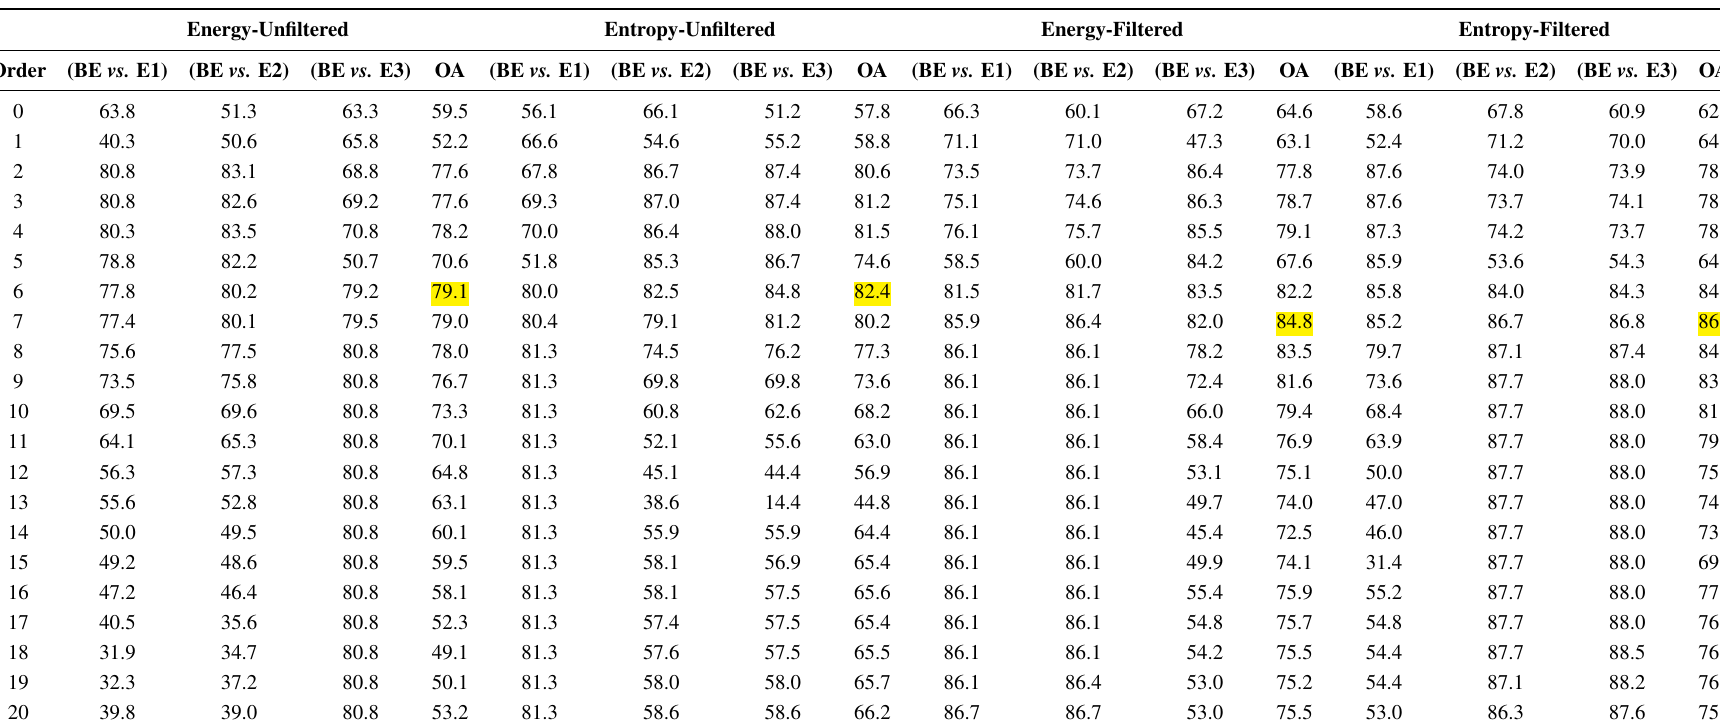
Table 3. Leave-one-out heat stress classification performance on PPG-chemical, biological and radiological (CBR) responders in the tropical condition database. Four classification methods are used in this analysis: linear discriminant analysis, quadratic discriminant analysis and the linear support vector machine. The PPG signals were collected from 40 heat acclimatized emergency responders for 20 s during the 10-minute break of each exercise ( cf. Figure 1). To evaluate the performance of each feature, we applied the F is defined as 2 × (SE × PP) / (SE + PP) . Here, OA stands for overall accuracy (average of F of each feature is